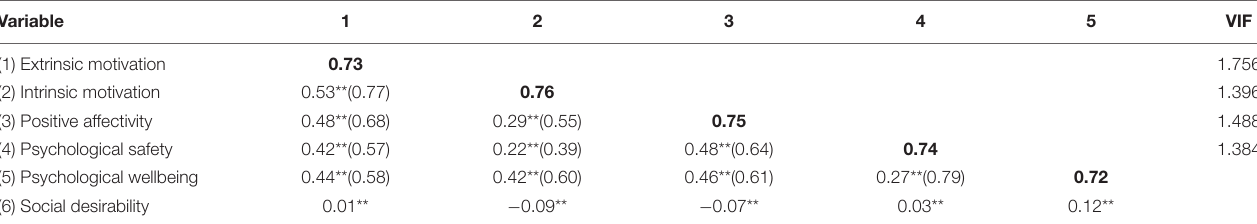
TABLE 3 | Discriminant